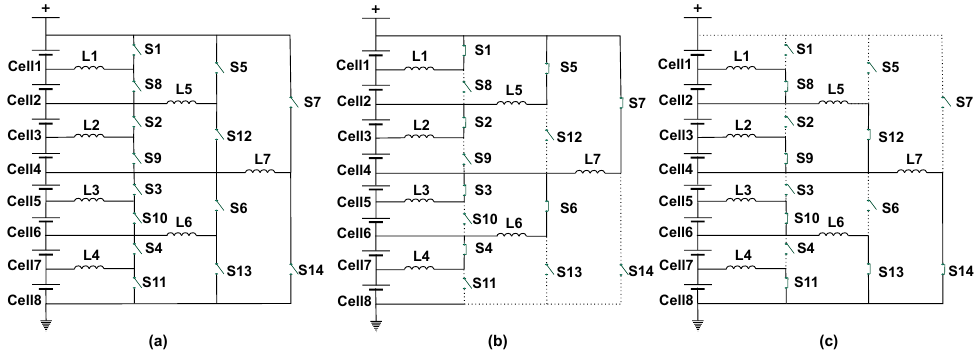
Figure 2. ( a ) Schematic diagram of the multiple inductor circuit. ( b ) The first stage of circuit operation closes switches S1 to S7. ( c ) The second stage of circuit operation closes switches S8 to